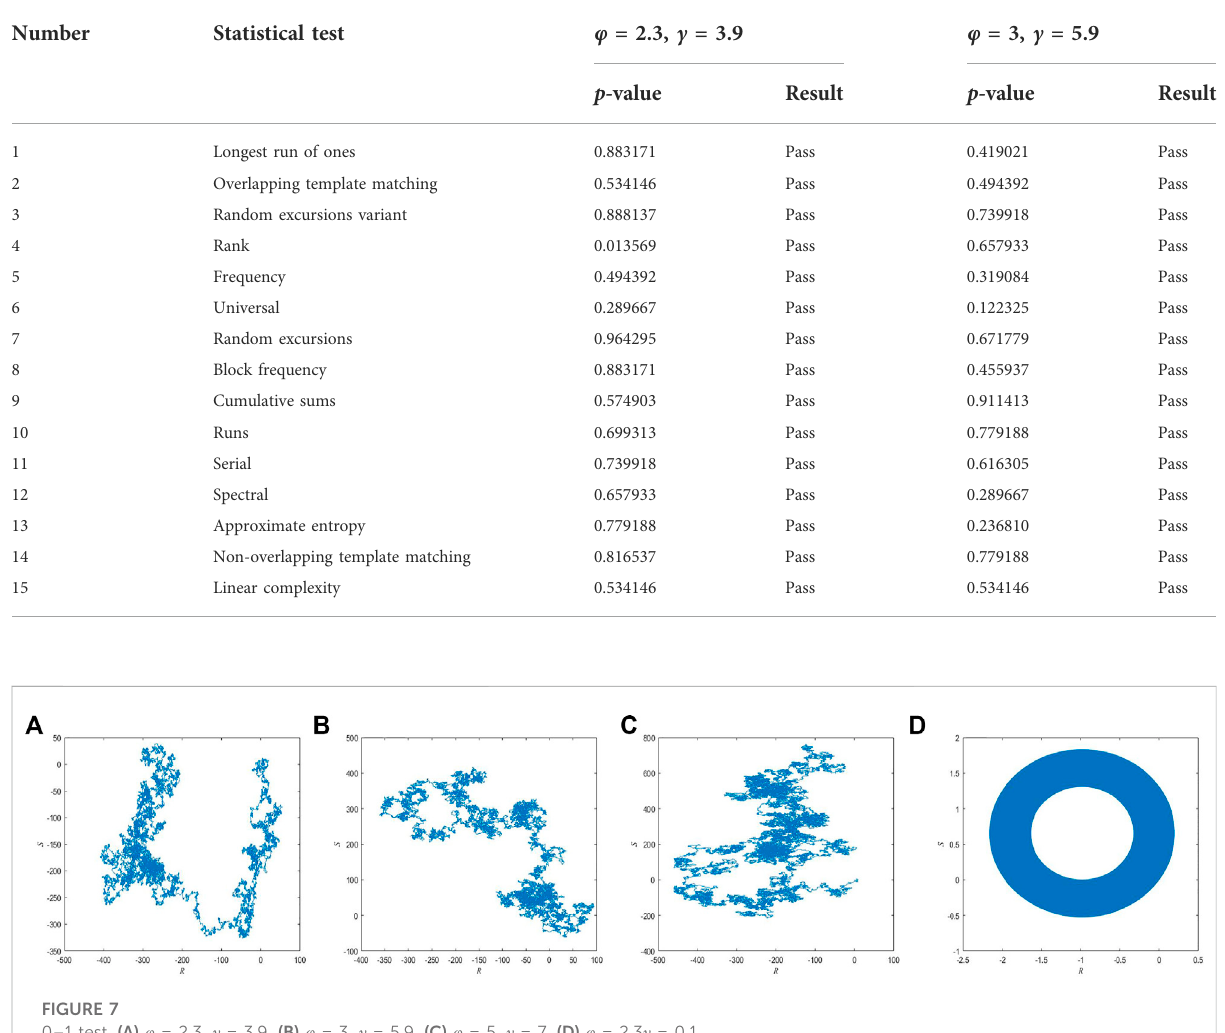
TABLE 1 NISTtest of 1D-SMCLM.